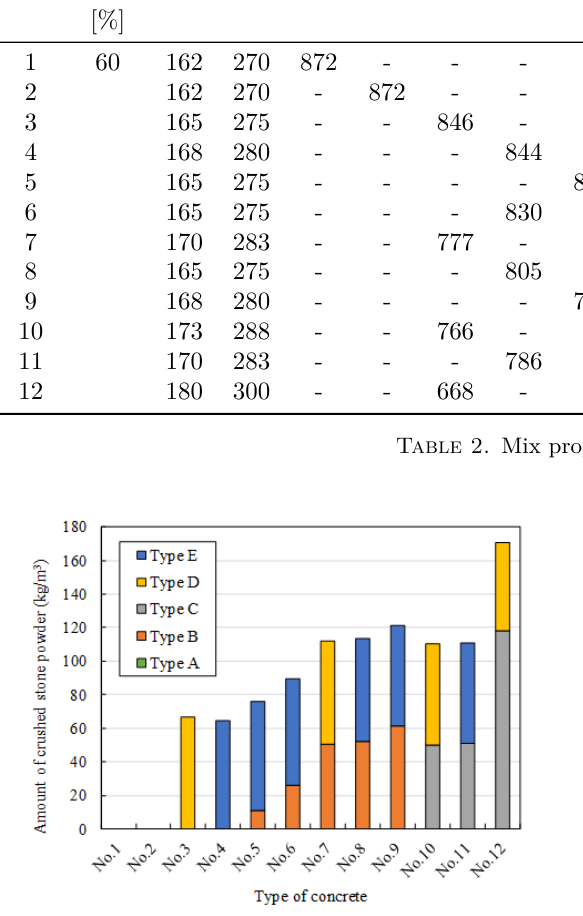
Figure 5. Unit water content of each mix